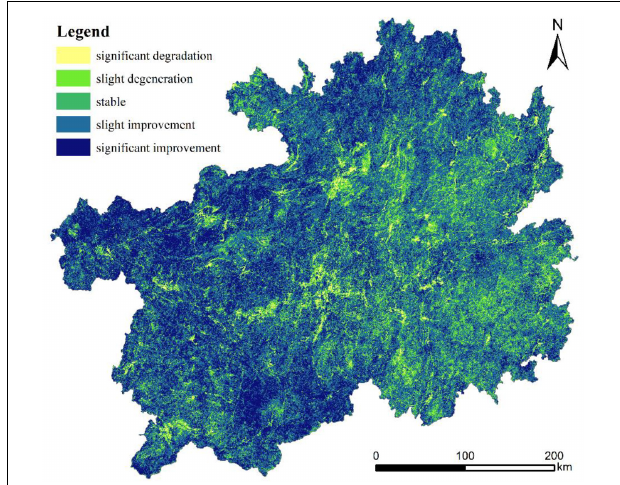
FIGURE 6 | Spatial S NDVI distribution in Guizhou Province between 2005 and